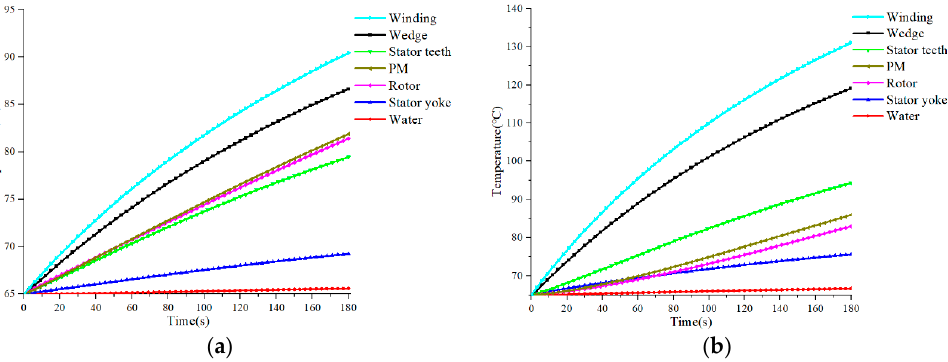
Figure 27. Temperature change curve under transient operating conditions: ( a ) high-speed conditions, ( b ) overload Conditions .